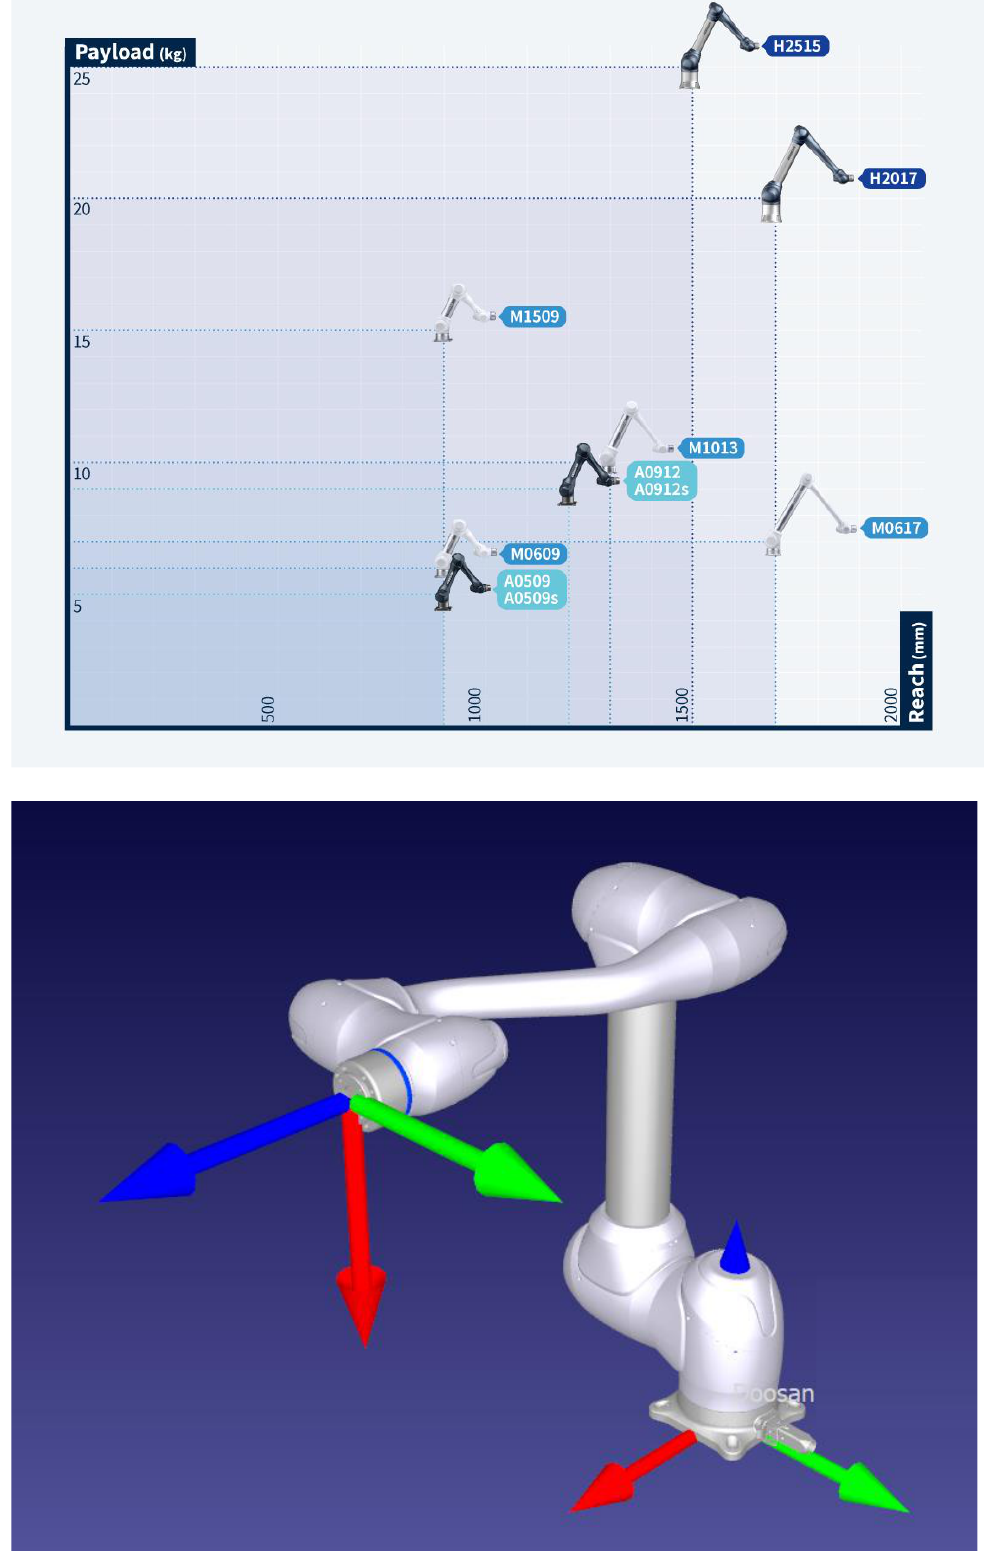
Figure 1. Collaborative robot from Doosan M0617.